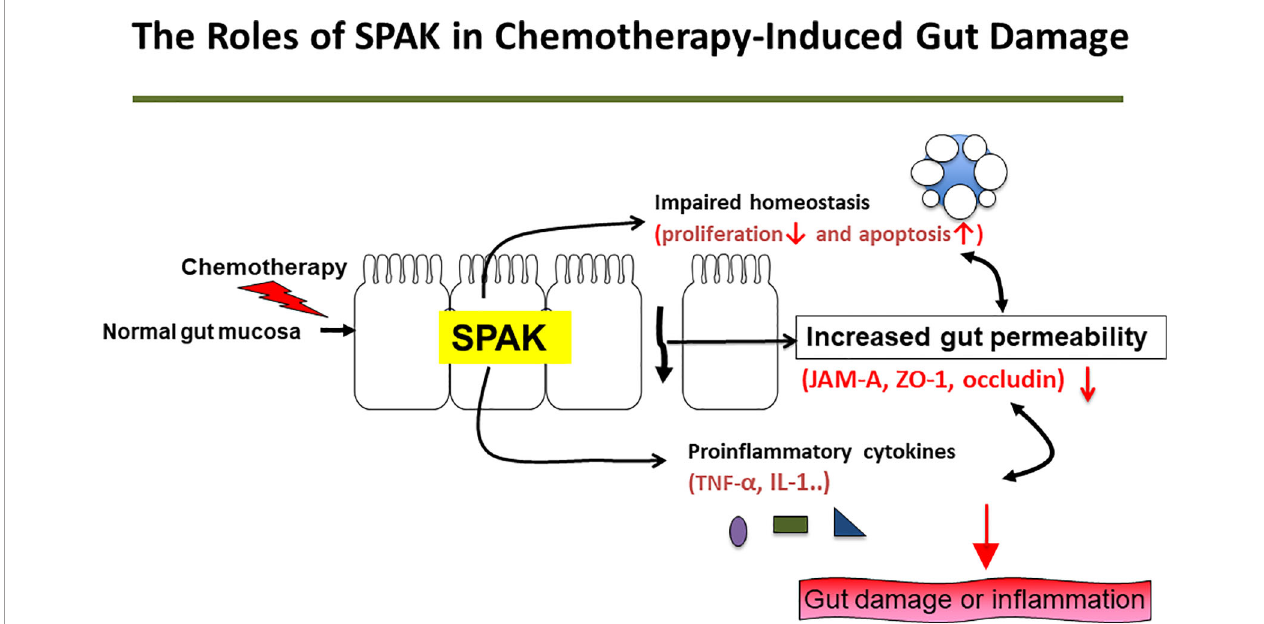
FIGURE 5 | Potential mechanisms underlying effects of SPAK in the pathogenesis of 5-FU-induced intestinal